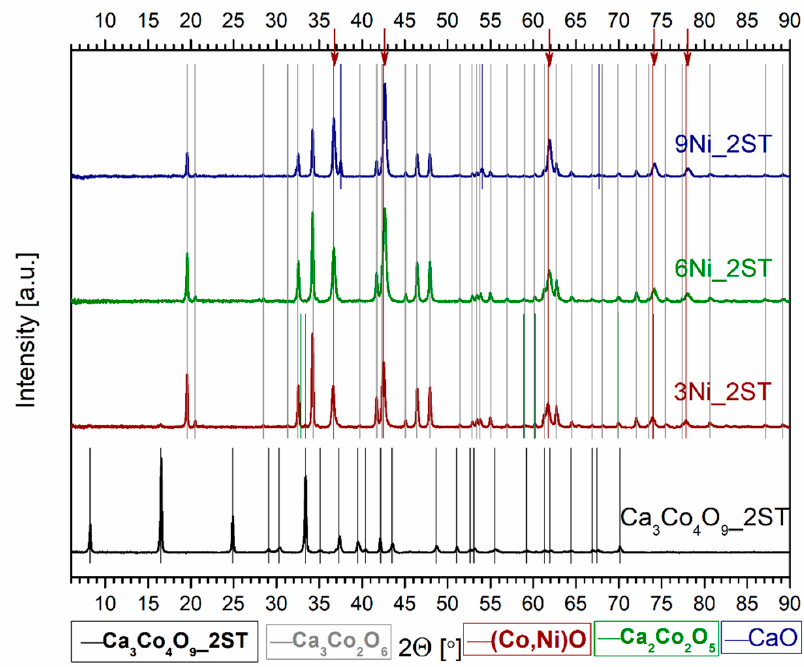
Figure 7. Normalized XRD patterns of the 2ST sintered reference matrix and Ni added samples. The vertical lines of different colors mark the main identified phases.